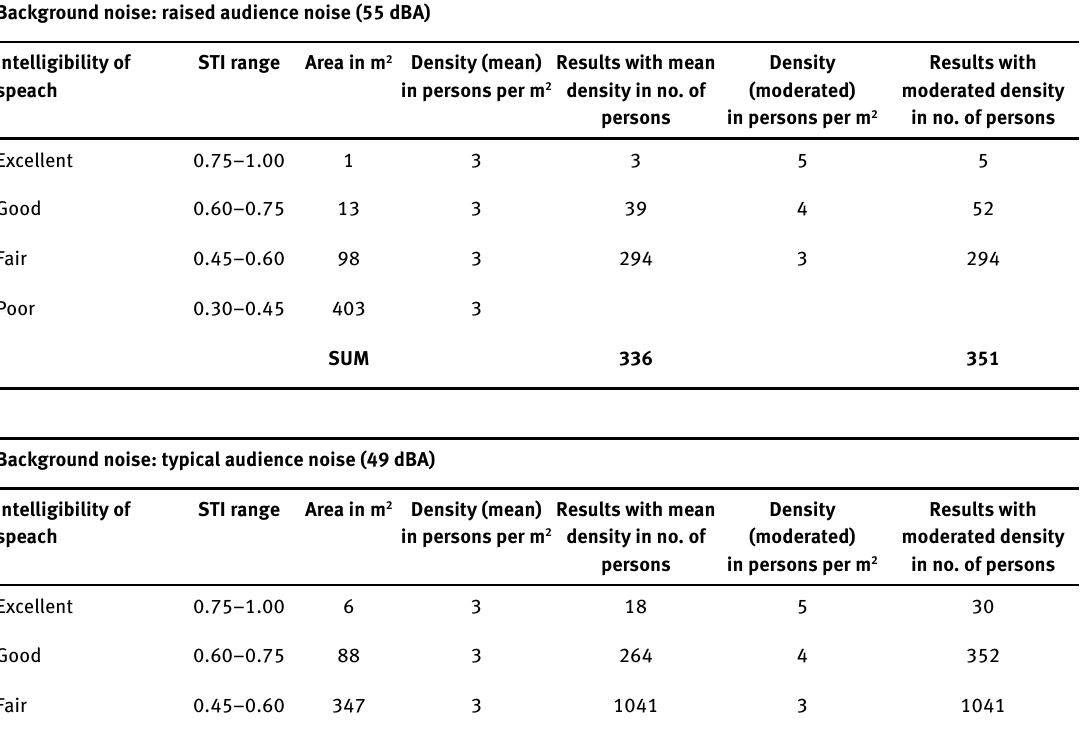
Table 5. Results for the